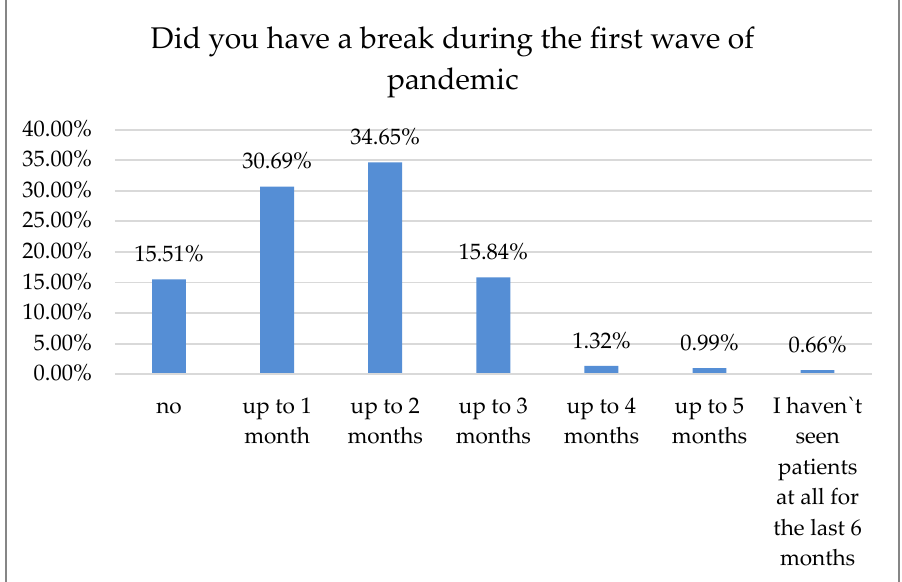
pandemic (Figure 4).